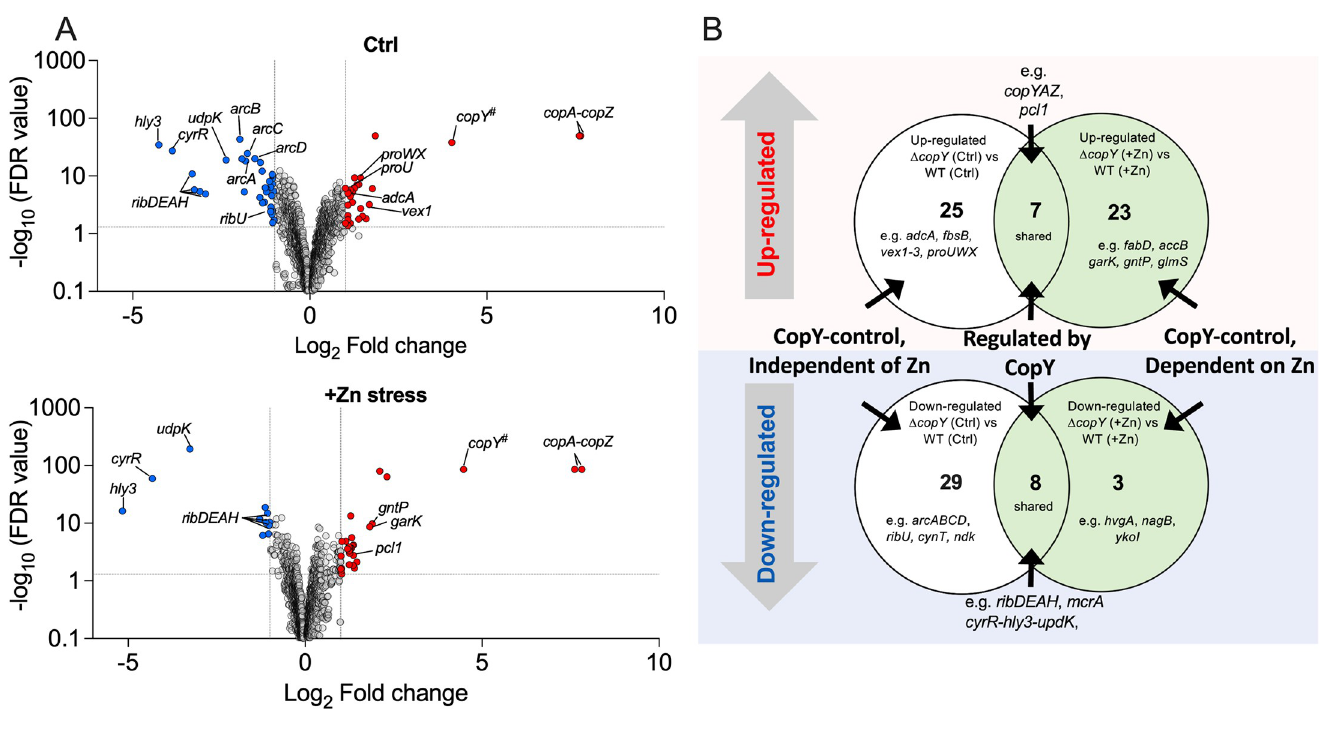
Fig 5. The CopY-responsive GBS transcriptome and the impact of Zn stress. (A) Volcano plots showing data from RNASeq of WT GBS cultures compared to Δ copY GBS in THB (Ctrl), or THB supplemented with 0.25 mM Zn (+Zn stress). Transcripts up- or down-regulated in response to Zn (n = 4, > ± 2-fold, FDR < 0.05) are highlighted in red and blue, respectively. Dotted lines show False discovery rate (FDR; q-value) and fold change cut-offs. Grey points indicate genes that were not significantly changed according to the defined cut-offs; selected genes are identified individually with black lines; # reads mapped to truncated copY gene in Δ copY strain. FDR values ( y -axes) were displayed by -log 10 (Y) transformation followed by plotting on a log 10 y-axis to generate volcano plots. (B) Venn comparison showing the number of up-regulated and down-regulated genes shared (Regulated by CopY) or unique to control (CopY-control independent of Zn) or +Zn stress conditions (CopY-control dependent on Zn); numbers in Venn comparison exclude non-coding transcripts such as tRNAs. The complete lists of genes and transcripts are available as S1 and S2 Data.